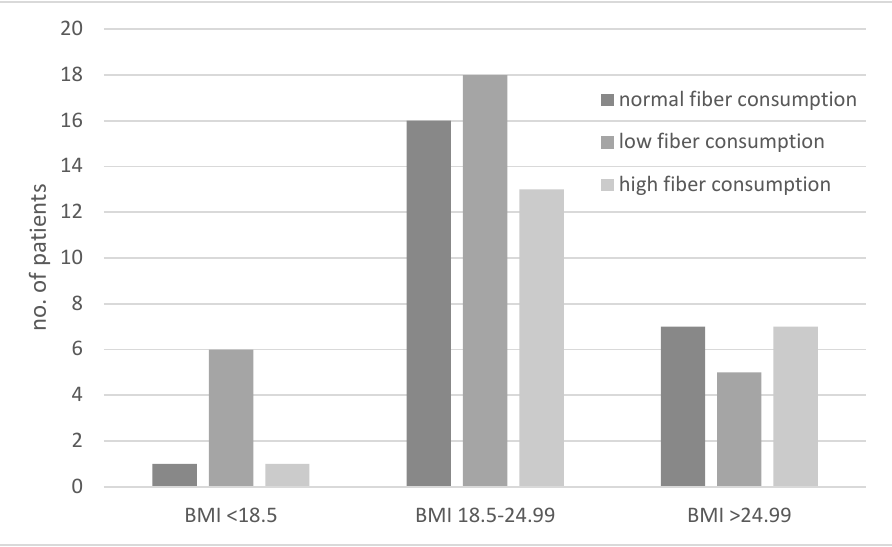
Figure 2. Consumption of diets with different fiber content (low, high, or normal) in patients with ulcerative colitis (UC), Crohn’s disease (CD), and controls. The consumption of diets with different fiber contents in the groups of underweight,